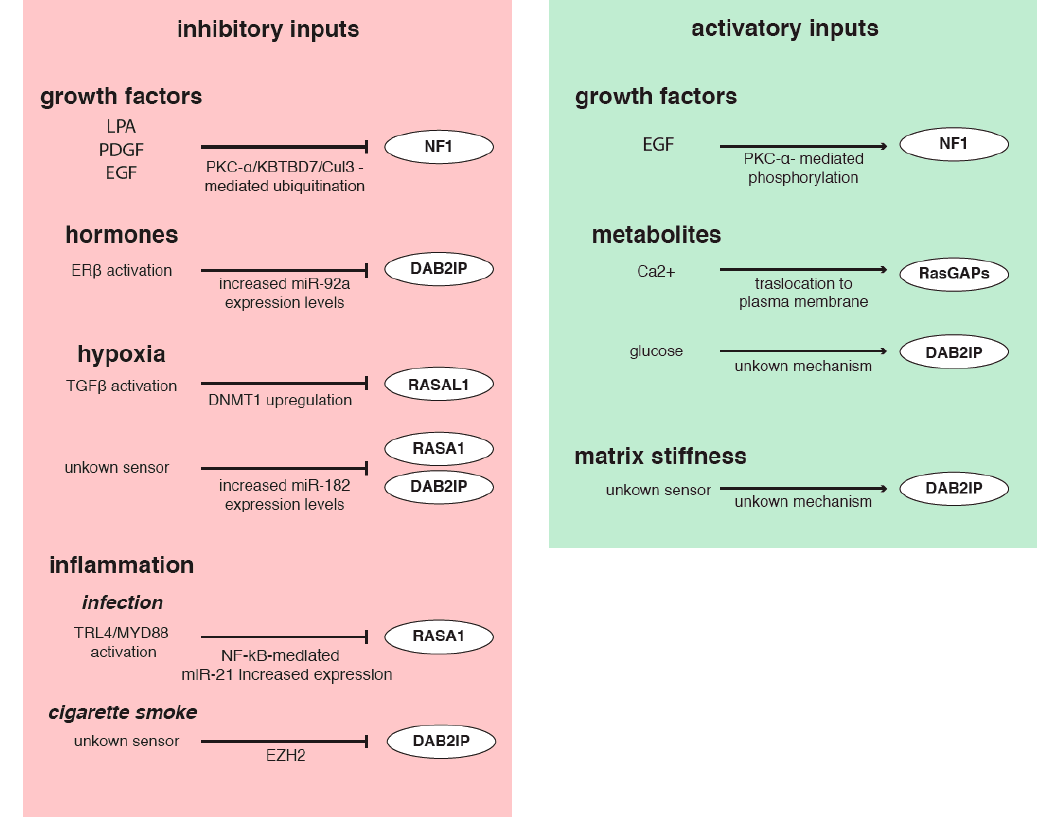
Figure 4. Multiple extracellular inputs can affect intracellular RasGAPs levels and activities in cancer cells. Schematic representation of extracellular signals that inhibit (red) or stimulate (green) expression and/or activity of RasGAPs, thus potentially affecting Ras signaling and oncogenic cell behaviors (see text for details).